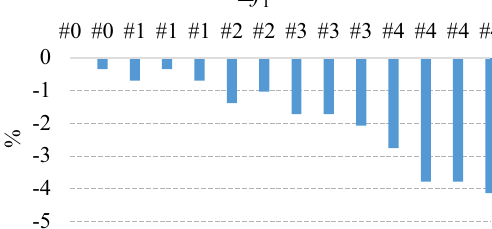
Figure 5. Changes of the first eigenfrequencies ∆ f 1 identified throughout the whole